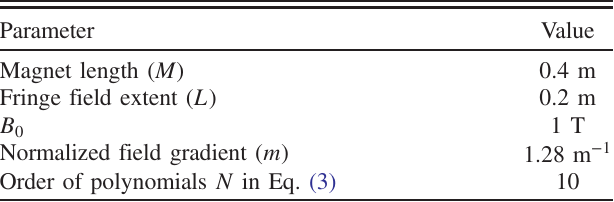
TABLE I. Dimension and strength of the magnet model shown in Fig.